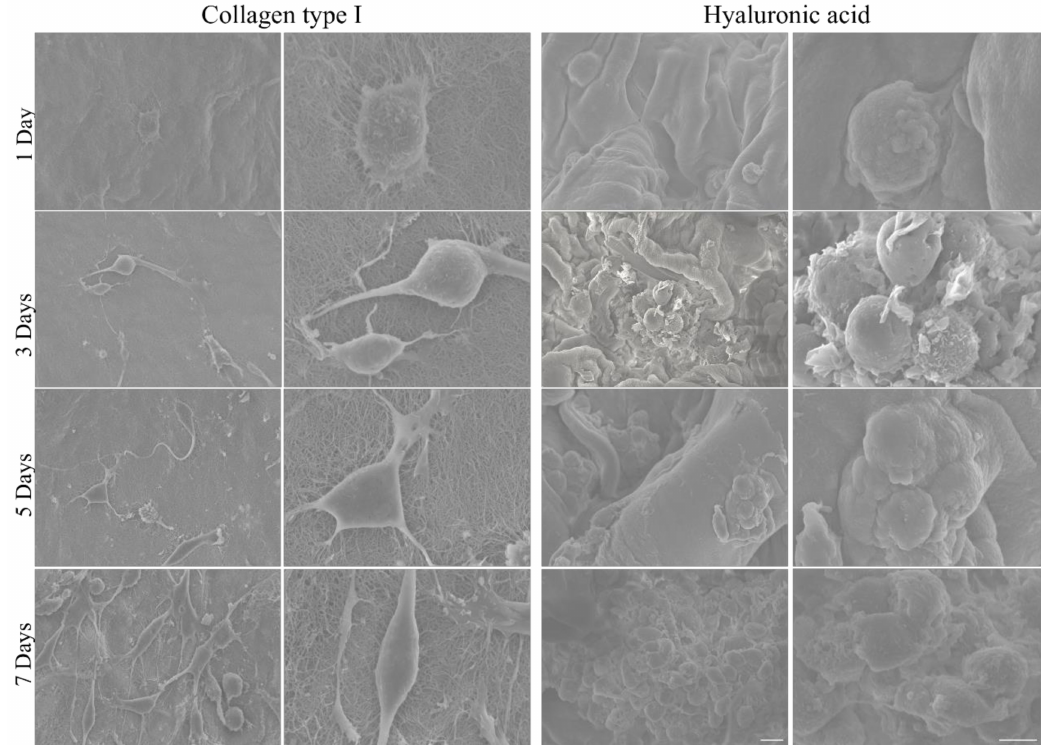
Figure 8. Cell morphology within the sca ff olds. Morphology of U87-MG cells was monitored over time, from day 1 to 7, via scanning electron microscopy. Cells included in COL gels were observed to alter their initial rounded shape into a more spindle-like, elongated morphology. This behavior is already observed at earlier time points. Cells included in HA gels grew into small clusters preserving their original rounded shape. Images on the right column panel of each gel (Collagen type I and Hyaluronic acid) represent higher magnifications of the related left ones. Scale bar = 50 µ